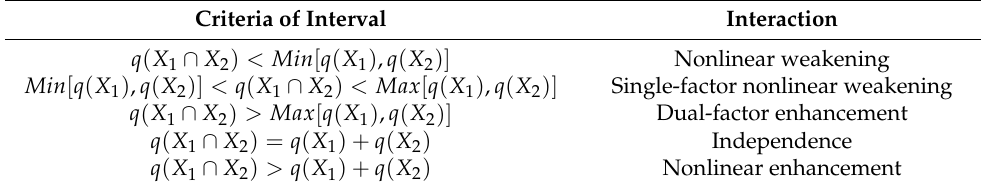
Table 2. Types of interaction between two covariates. Criteria of Interval